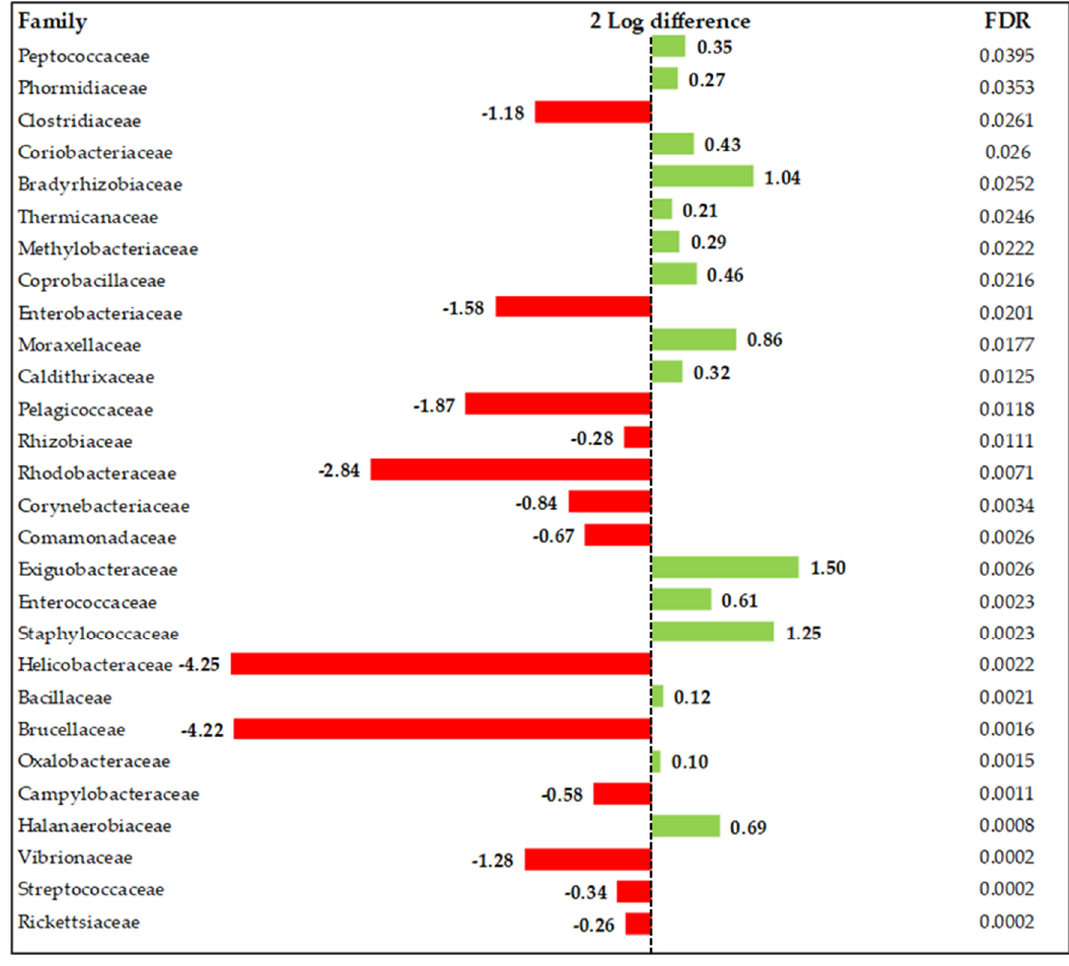
Figure 2. Relative abundance (%) of the main phyla ( a ), families ( b ), and genera ( c ) present in the ileal microbiota of broiler chickens at d 41 of age (Trial 1). NC: Negative control; OA1: Malic acid + fumaric acid; OA2: Calcium butyrate + fumaric acid; OA3: Calcium butyrate + fumaric acid + citric acid + MCFA; MCFA: Capric-caprylic acid + caproic acid + lauric acid; AC: Cinnamaldehyde, carvacrol, and thymol as major compounds).